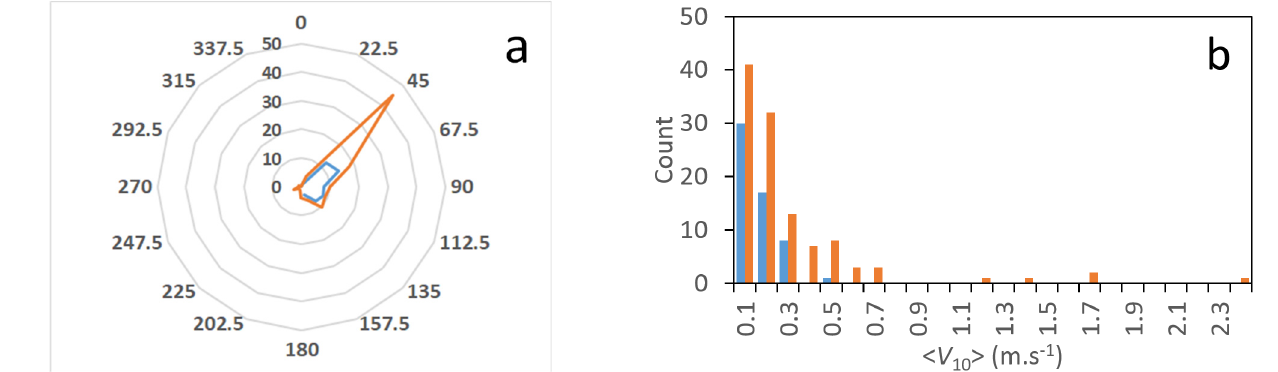
Figure 3. ( a ). Mean number of events with respect to the wind direction at night (21 h − 7 h) between 15 July and 30 November 2020. Orange lines: all nights; blue line: only nights with dew events. ( b ) The corresponding distribution of windspeed at 10 m.